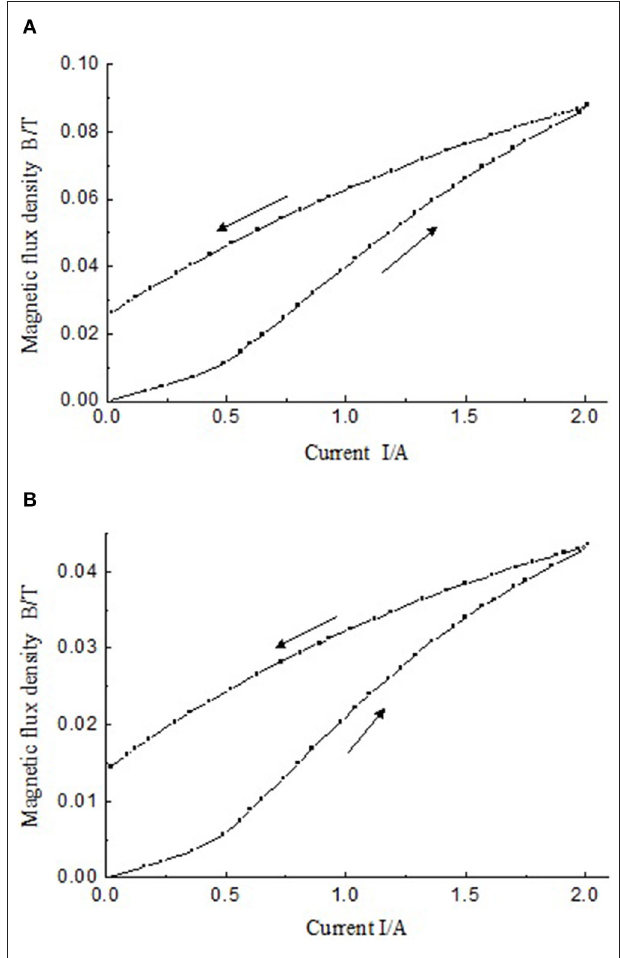
FIGURE 6 | Magnetic hysteresis curves measured by the sensors installed on circular surfaces of the piston of the MR fluid damper. (A) First sensor; (B) Second